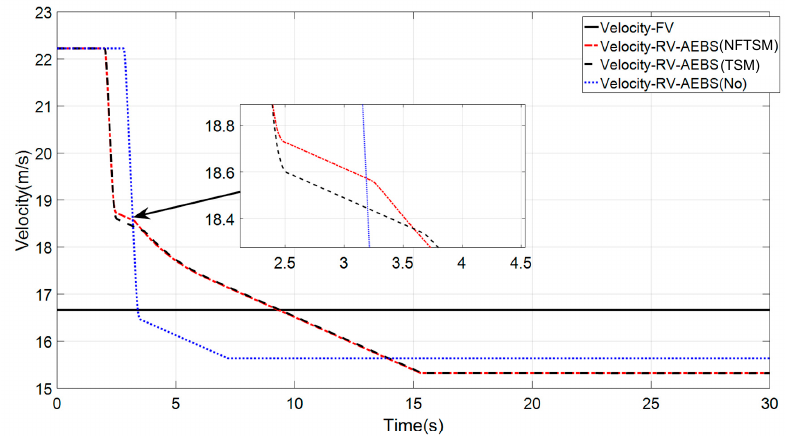
Figure 17. Comparison of relative speed.